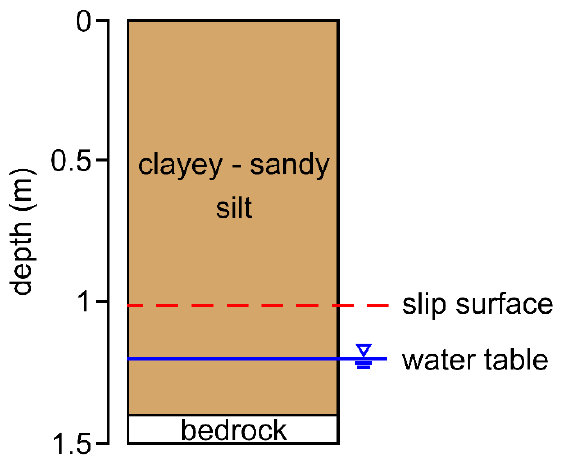
Figure 5. Soil profile of the considered site, indicating the location of the observed water table and that of the slip surface (adapted from